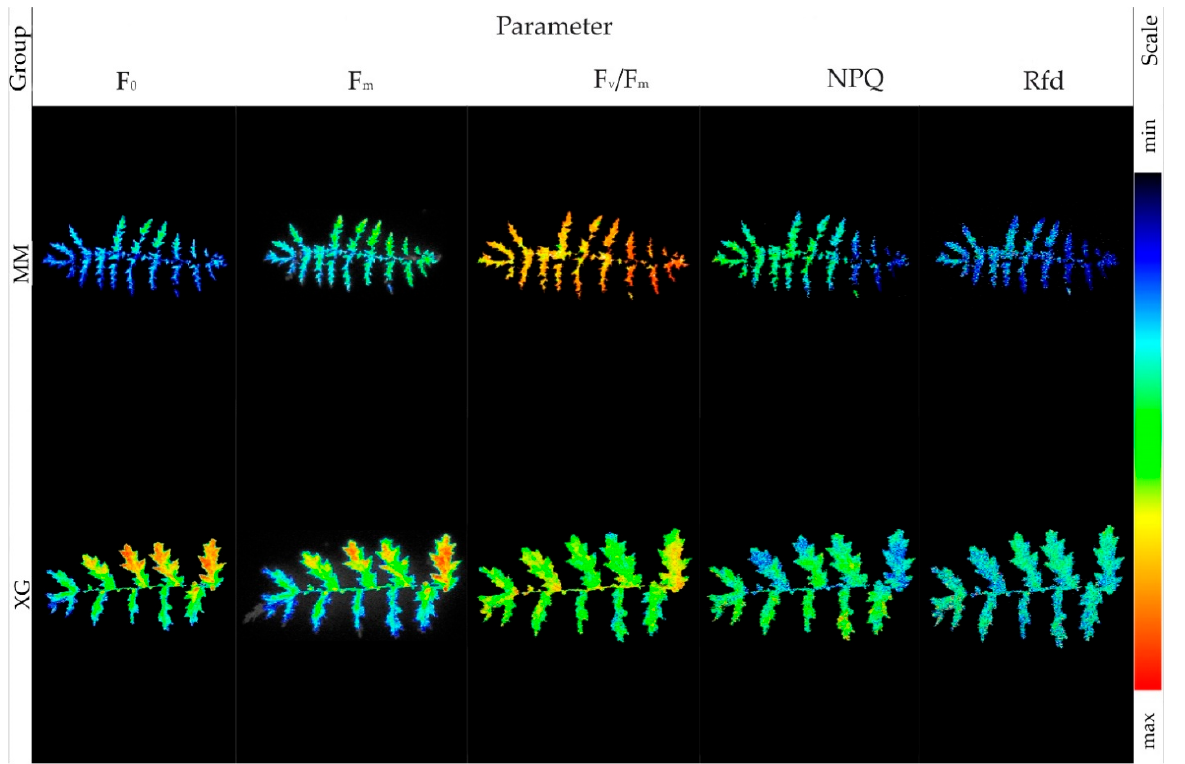
Figure 2. Imaging of chlorophyll a fluorescence of leaves of Filipendula vulgaris Moench specimens collected from Molinia meadows (MM) and xerothermic grasslands (XG).